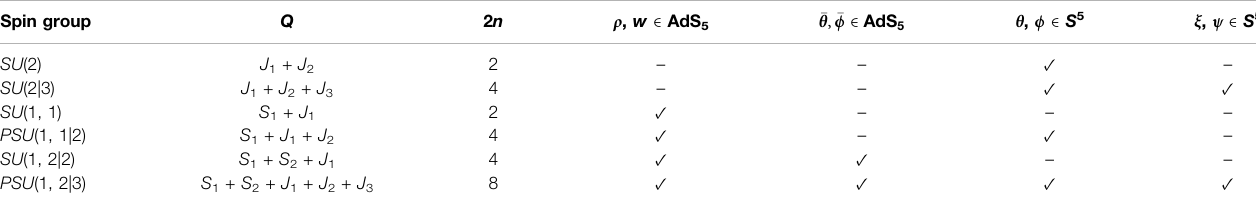
TABLE 1 | The Spin Matrix theories arising from the near-BPS limit Δ ≥ Q for charge combinations with integer coef fi cients, the 2 n spatial dimensions of their target space in the bulk and their AdS 5 × S 5 origin. The associated U (1)-Galilean geometry can be obtained from appropriate restrictions of the PSU (1, 2|3) result in Eq. 5.23 . Spin